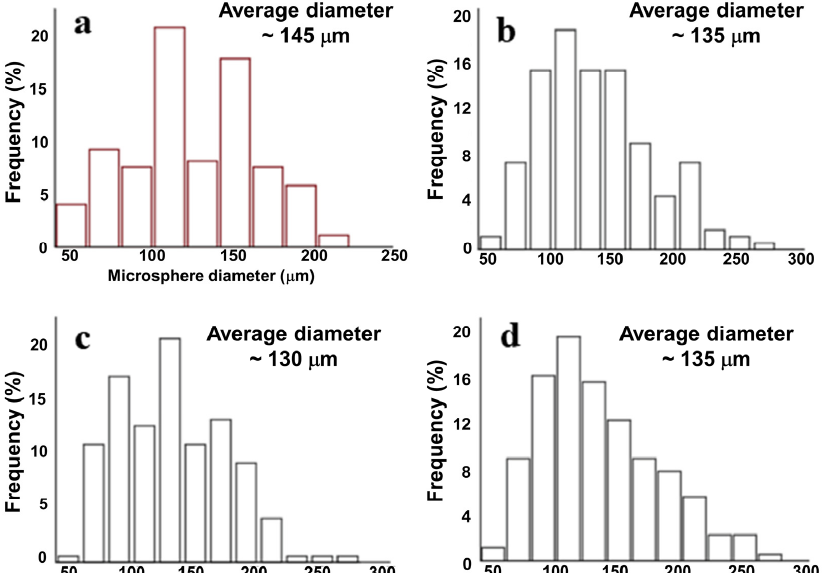
Figure 3. An average diameter and size distribution of cell encapsulated microspheres: ( a ) A HSF cell-encapsulated microsphere (density of 0.50 × 10 7 /mL); ( b ) RAW246.7 cell-encapsulated microsphere (density of 0.50 × 10 7 /mL); ( c ) RAW246.7 cell-encapsulated microsphere (density of 1.00 × 10 7 /mL); ( d ) RAW246.7 cell-encapsulated microsphere (density of 1.50 × 10 7 /mL).